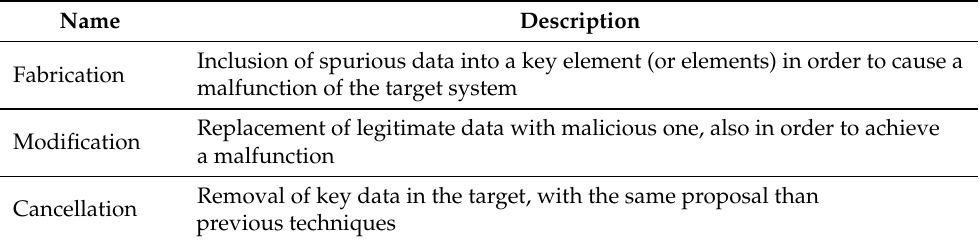
Table 3. Manipulation